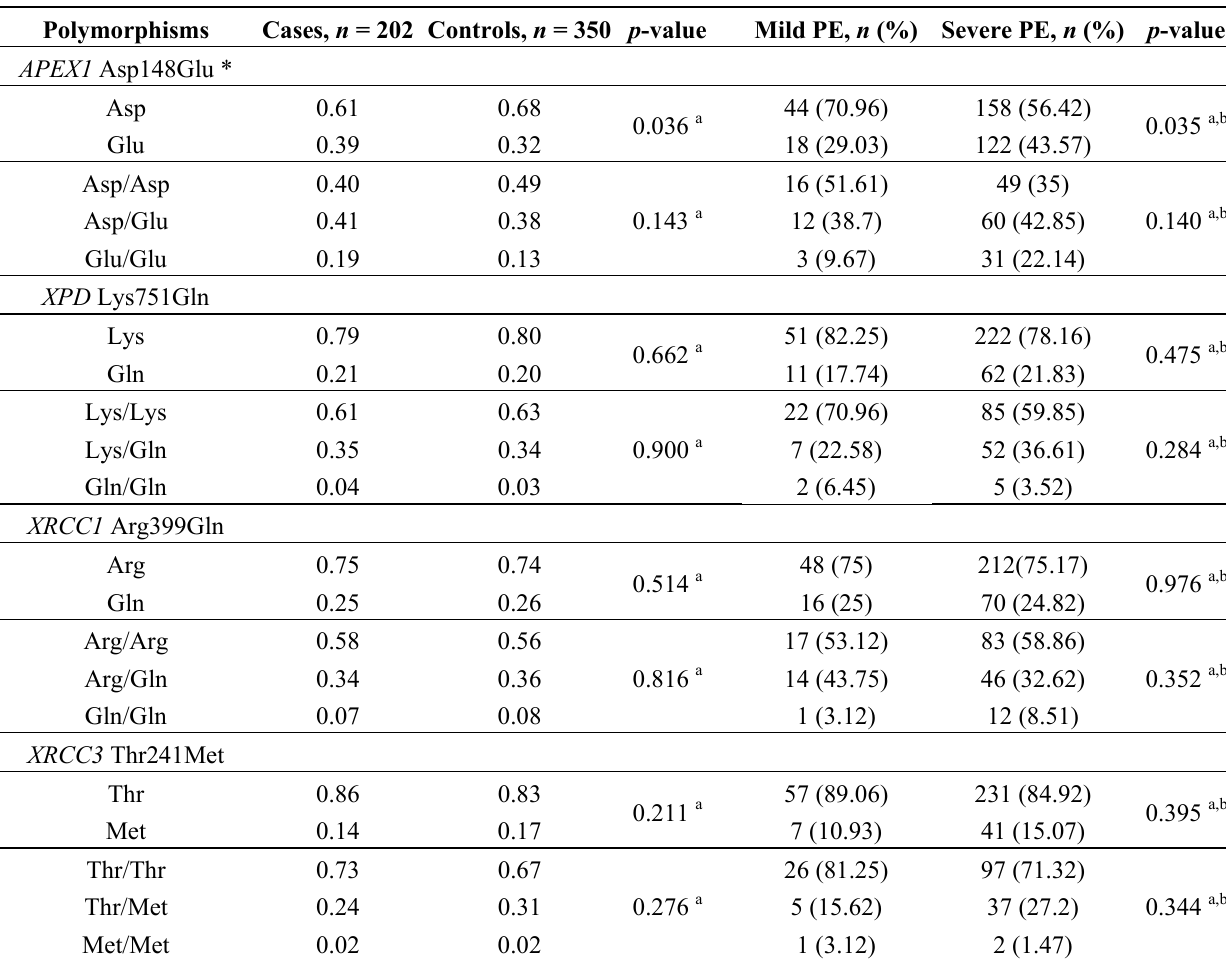
Table 2. Allele and genotype frequencies of APEX1 Asp148Glu, XPD Lys751Gln, XRCC1 Arg399Gln and XRCC3 Thr241Met polymorphisms in preeclamptic (cases), healthy pregnant women (controls) and mild and severe preeclamptic women